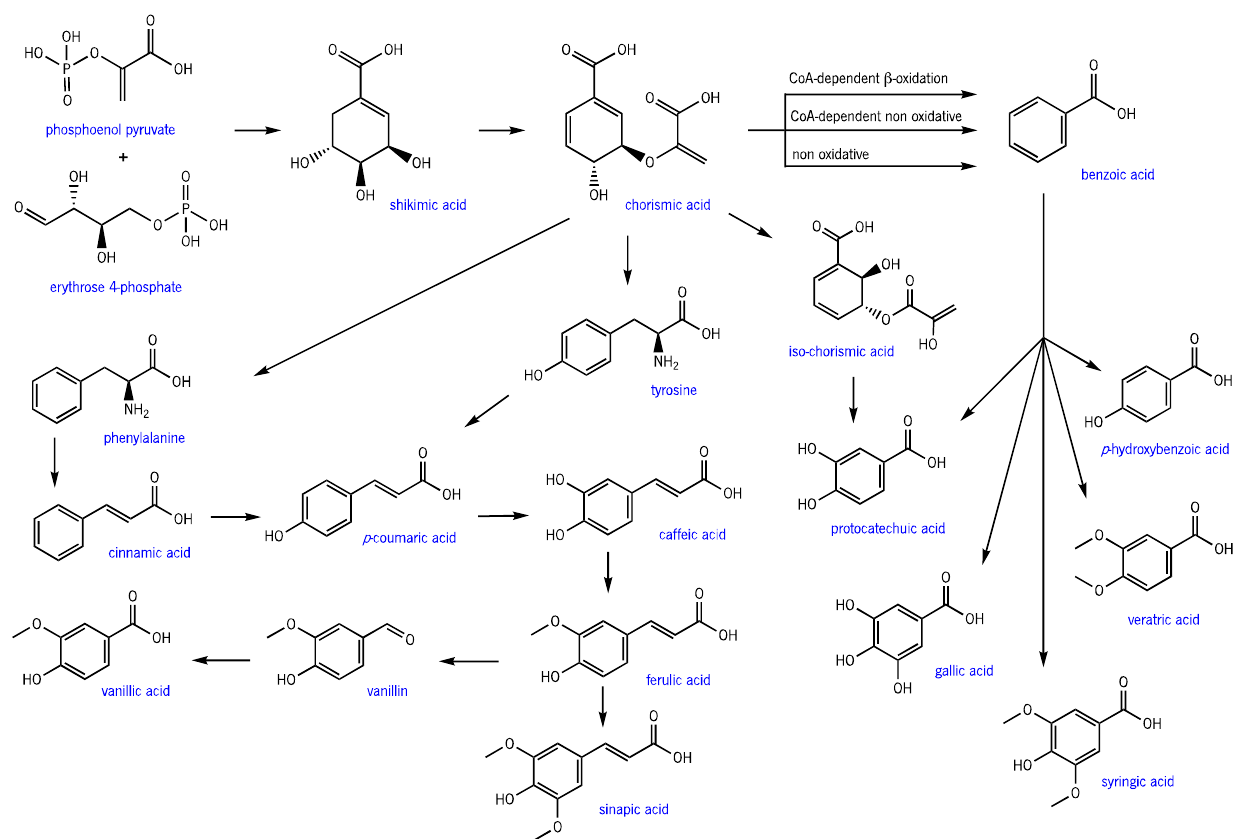
Figure 4. Shikimate pathway for phenolic compound biosynthesis in plants (adapted from [19]).